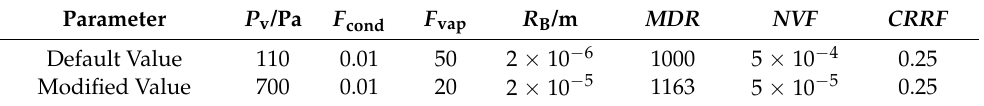
Table 4. Parameter modification on torque converter cavitation